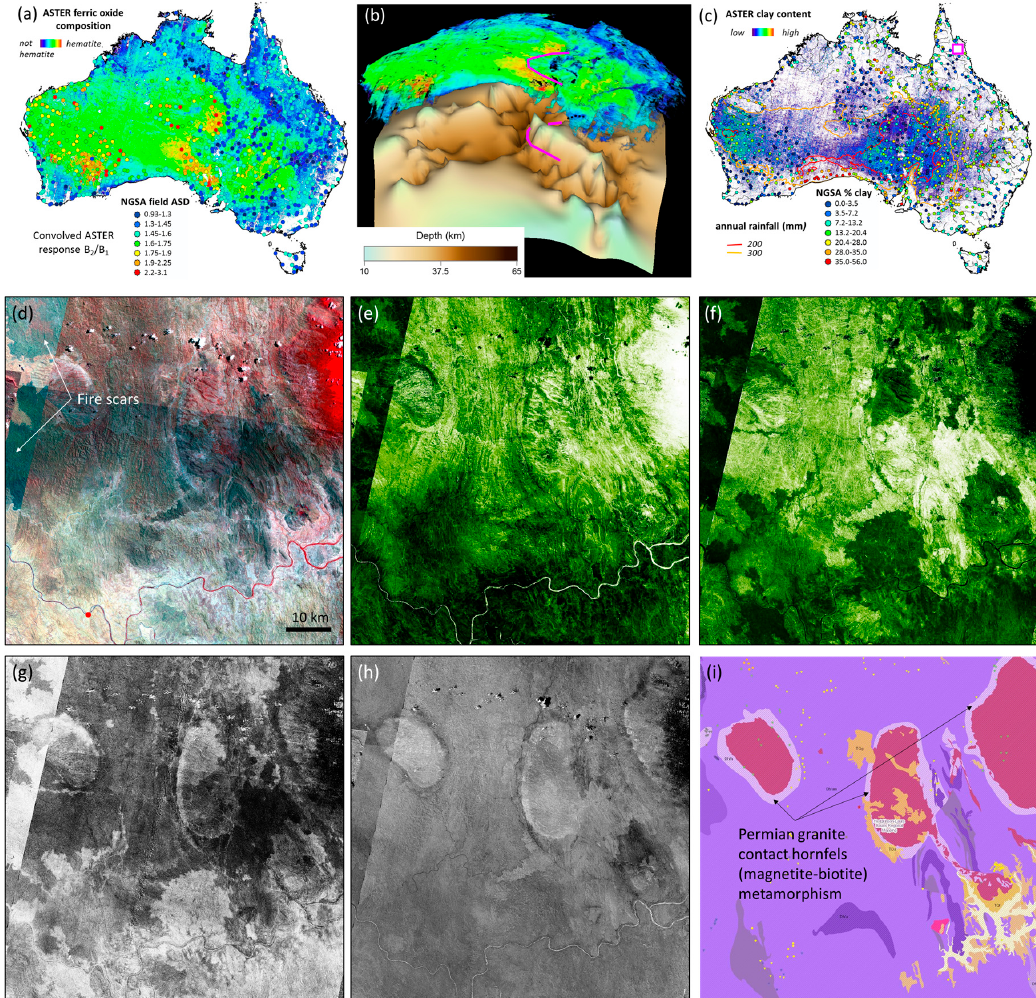
Figure 15. ( a ) ASTER V1 Ferric Oxide Composition map of Australia [135] with similarly processed field validation ASD measurements of the field NGSA surface samples (0–10 cm depth) [136] (colored dots); ( b ) Oblique view from south of the Australian ASTER ferric composition and Mohorovi č i ć Discontinuity (MOHO) maps [137]. The edge of a high in the MOHO is marked by a magenta line which mirrors a change in the surface iron oxide information; ( c ) ASTER V1 Al-clay content map of Australia together with rainfall and field validation NGSA %clay data; ( d ) ASTER false color image of the Mt Carbine area, NE Queensland. Scene center is approximately − 16.4104° latitude 144.6905° longitude; ( e ) ASTER green vegetation index B 3 /B 2 ; ( f ) ASTER dry vegetation index; ( g ) ASTER Al-clay content before vegetation unmixing; ( h ) ASTER Al-clay content after vegetation unmixing; ( i ) Published geology, which shows granites rimmed by contact metamorphic hornfels aureoles where minerals such as muscovite were replaced by biotite.